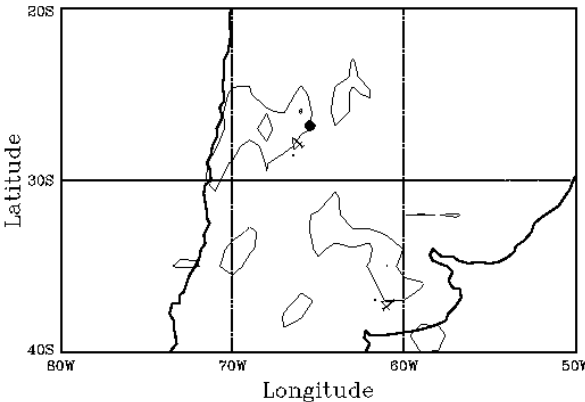
Fig. 17. Case 1: Results of the ECMWF reanalysis. Lagrangian Rossby number contours at the 15km altitude. For clarity, only the values of the LR number above the threshold 0.4 are displayed. Salta is indicated by a